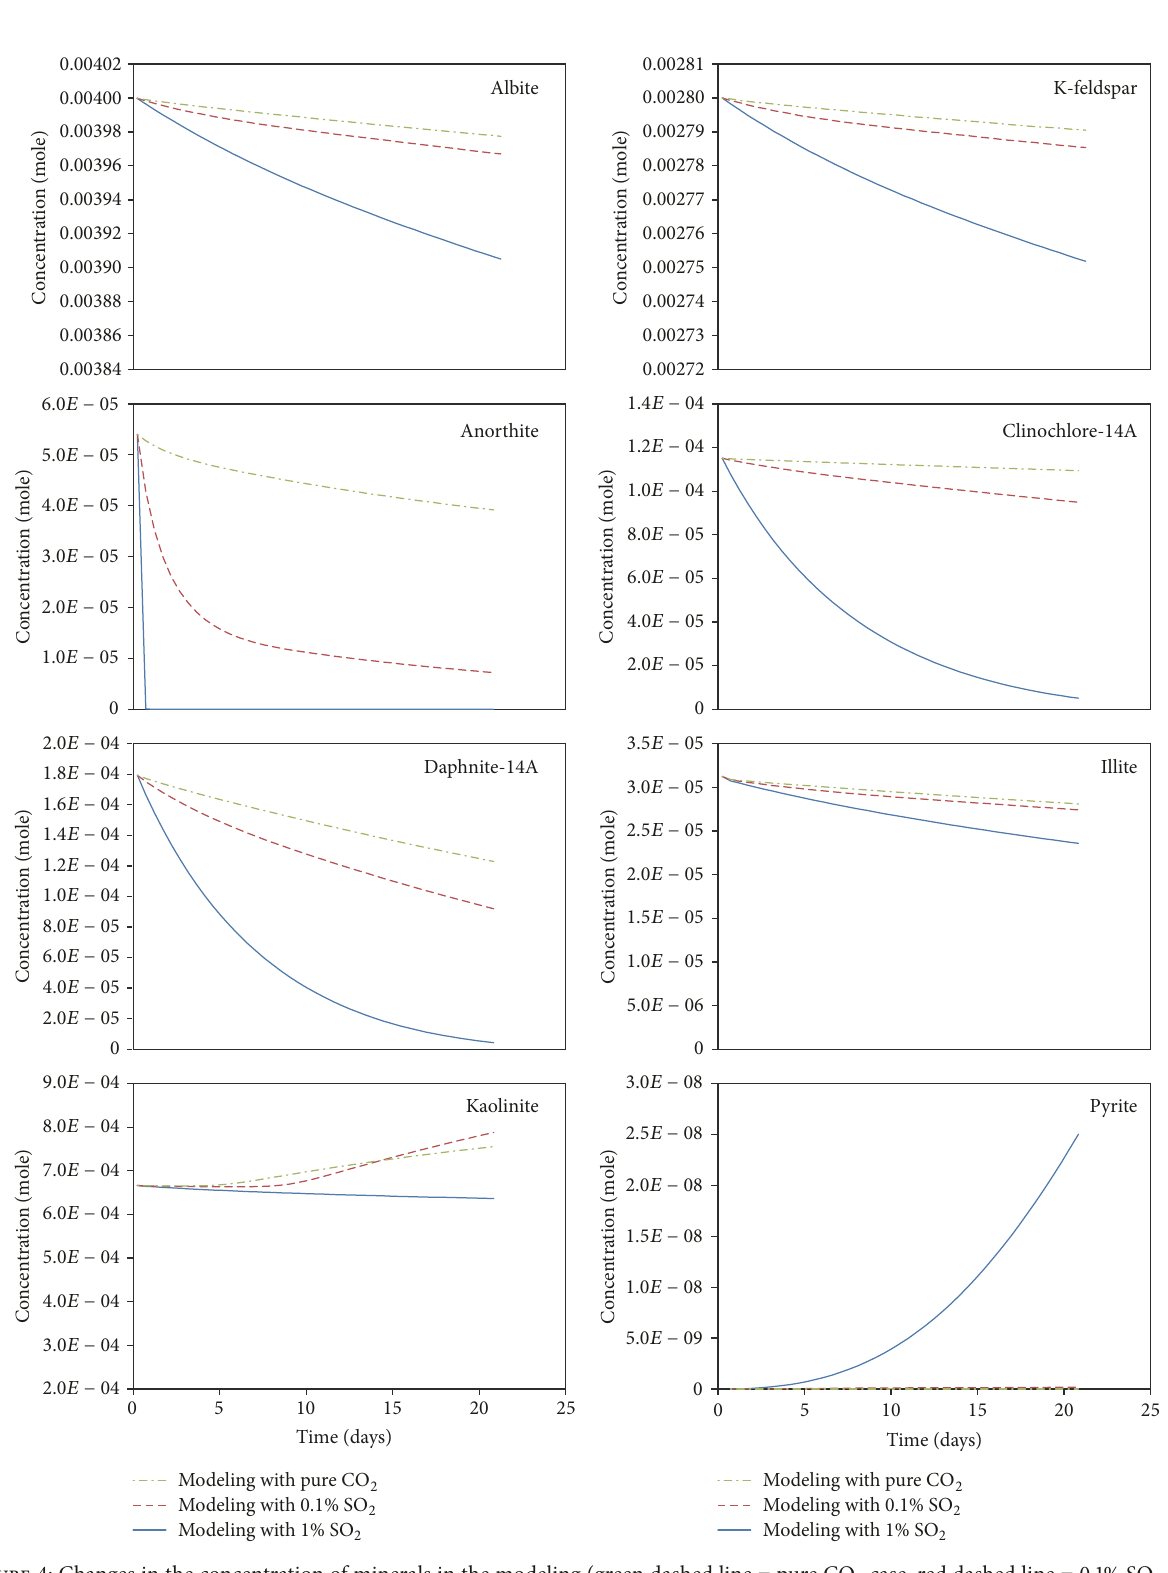
Figure 4: Changes in the concentration of minerals in the modeling (green dashed line = pure CO 2 case, red dashed line = 0.1% SO 2 case, and blue solid line = 1% SO 2